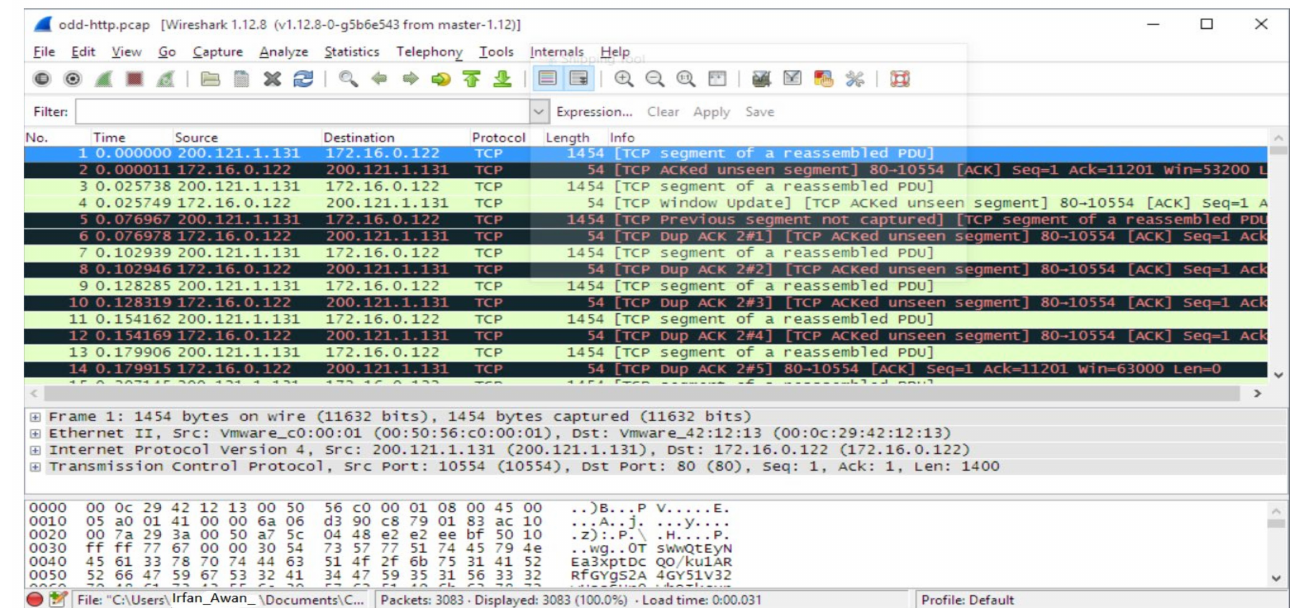
Figure 11. TCP traffic of the false positive detection units.